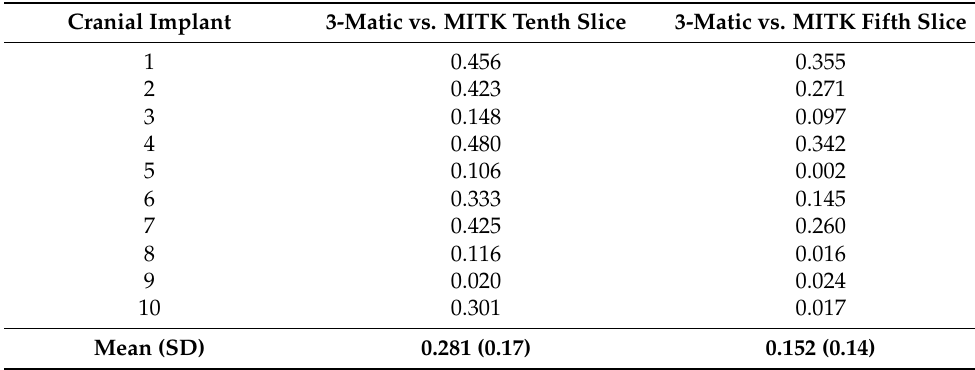
Table 2. Geometric analyses (HD) of cranial implants. Cranial Implant 3-Matic vs. MITK Tenth Slice